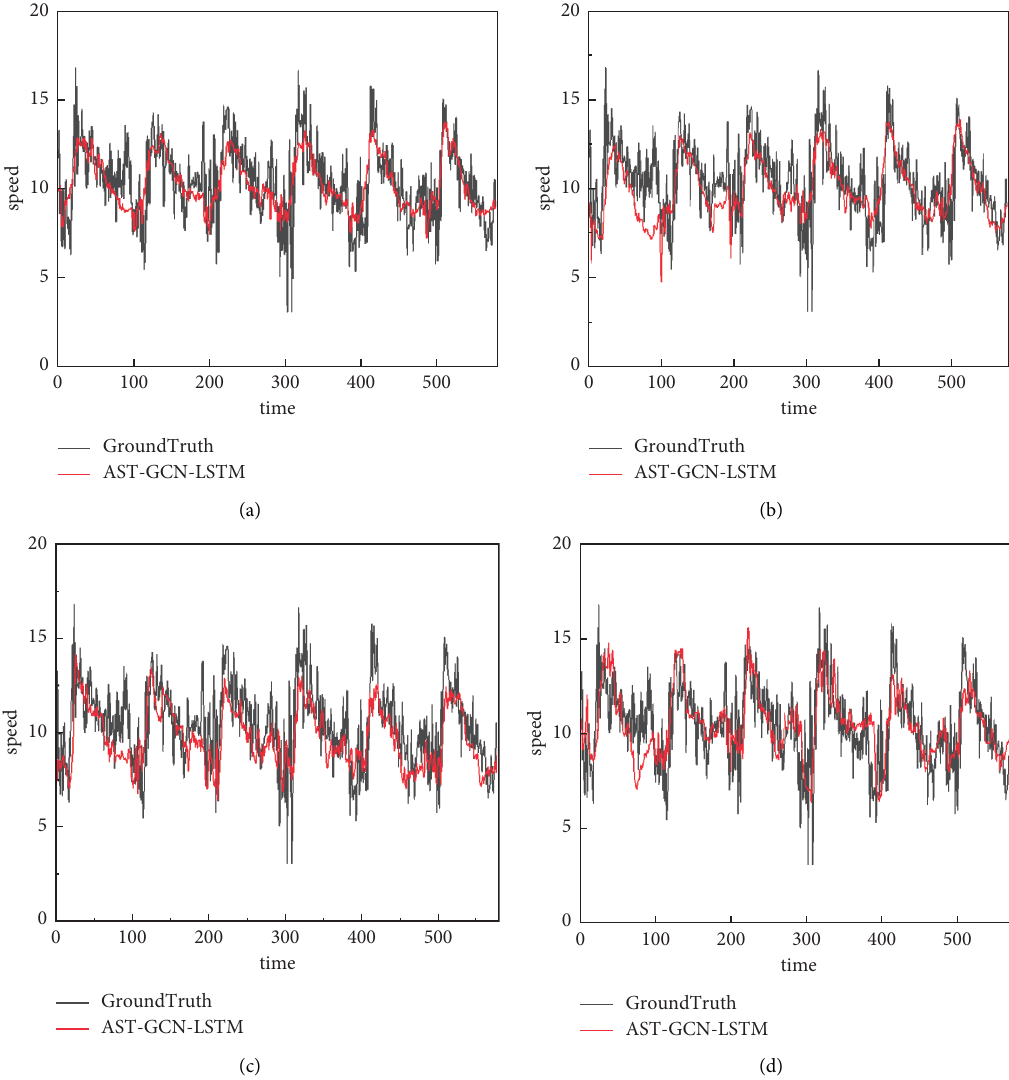
Figure 6: Visualization of the prediction window. (a–d) The prediction effect of 15, 30, 45, and 60 Table 2: Performance comparison of different prediction